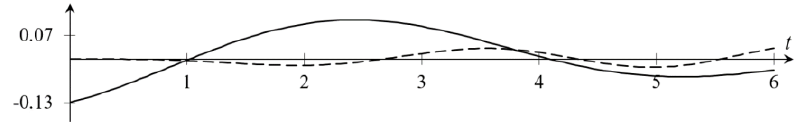
Figure 2. Graphs of the functions V 1 ( t ) (solid line) and V 2 ( t ) (dashed line). The graphical representation of the functions Q 1 ( x , 0 ) , Q 2 ( x , 0 ) and ϕ 0 ( x ) is illustrated in Figure 3.